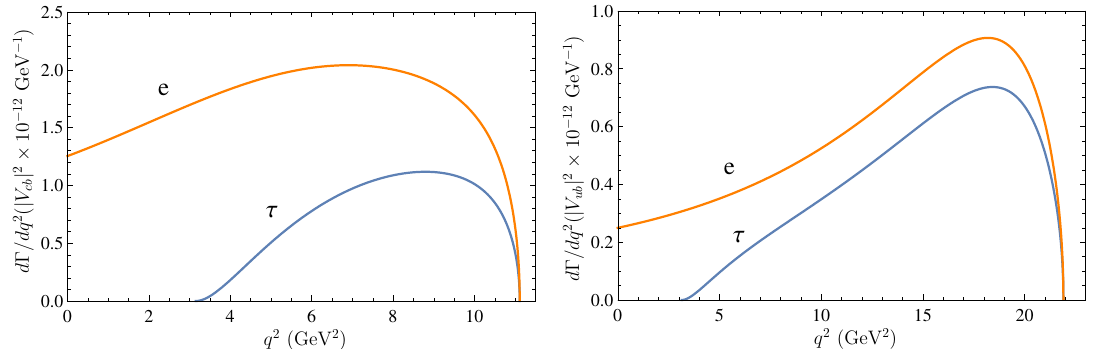
Λ Λ c l ν ( left ) and b → pl ν (right ) →